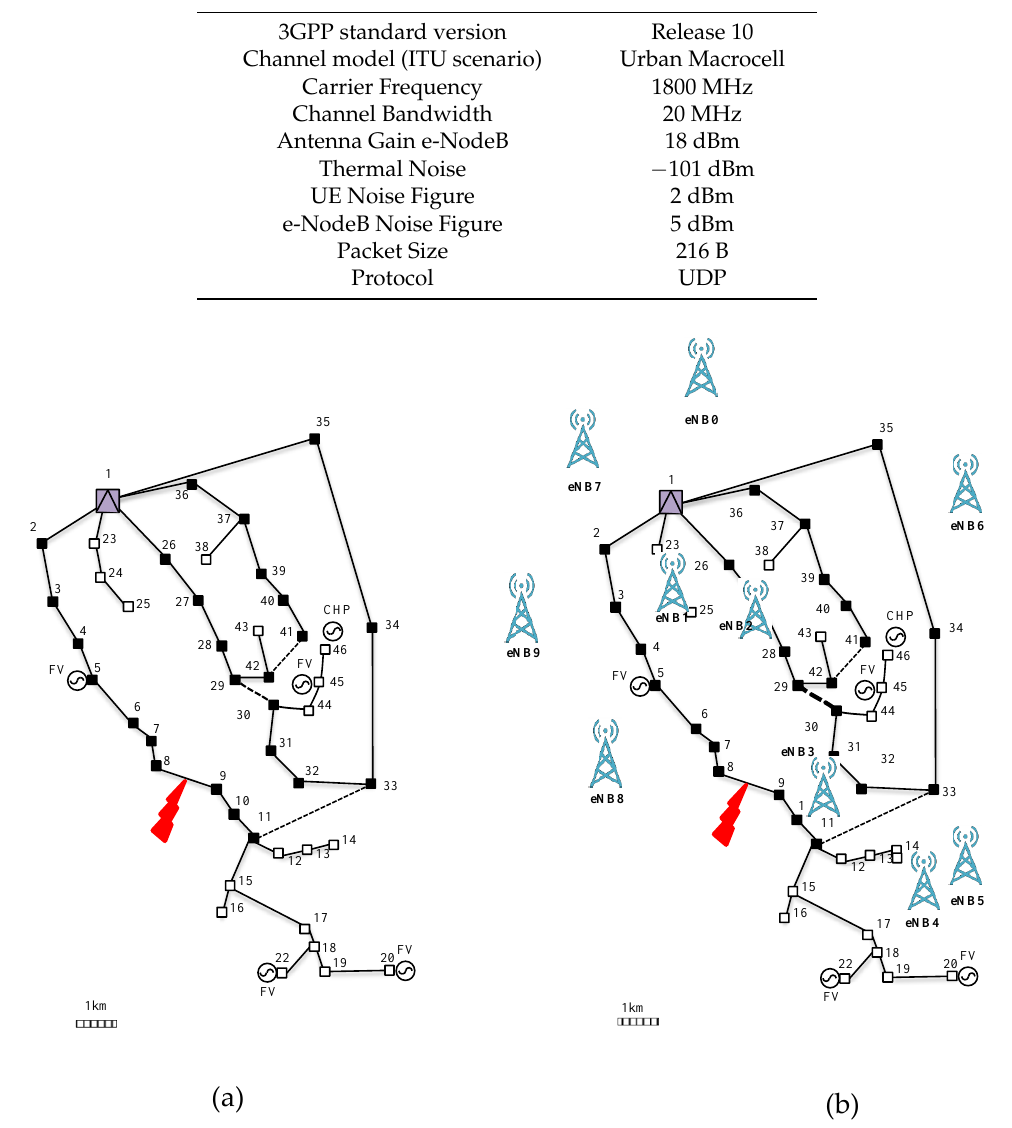
Figure 8. Case study: ( a ) Distribution network, ( b ) superimposed mobile LTE communication network.